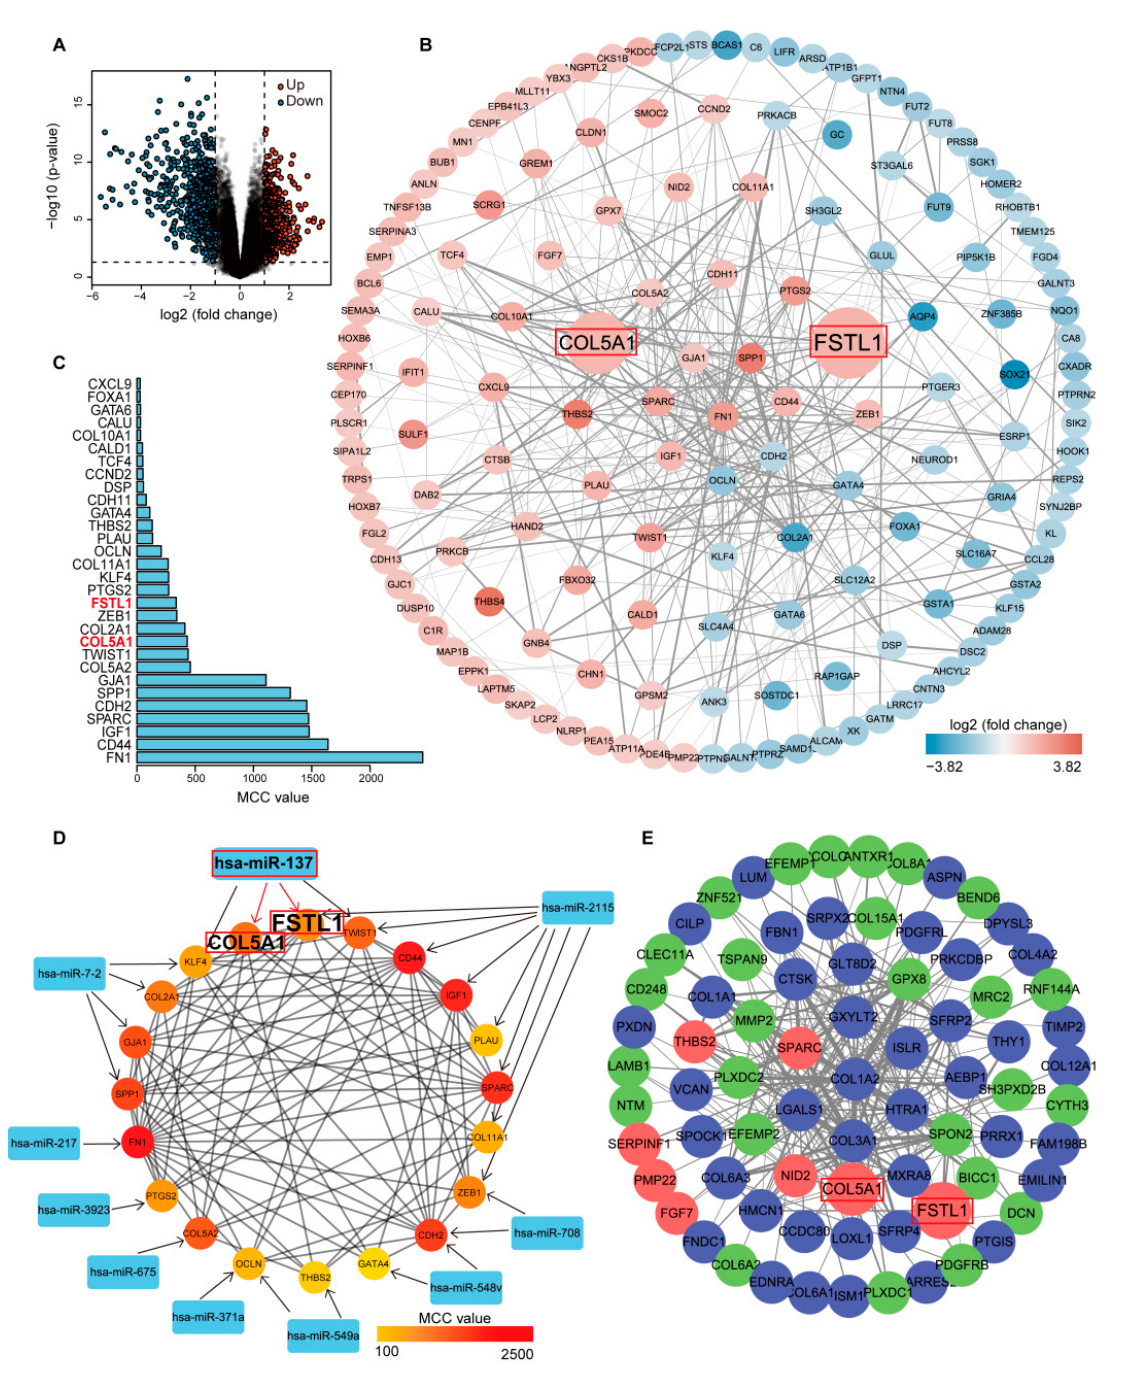
Figure 2. Mining of hub genes in GC. ( A ) Volcano plot of DEGs in GSE118916. ( B ) PPI network of DETGs. Red represents upregulation, and blue represents downregulation. The color of the node deepens as the value of |log 2 FC| increases. ( C ) Genes with the top 30 MCC values in the PPI network. ( D ) The PPI network of 20 hub genes and the SRDEMs that target these genes. The color of the node deepens from yellow to red as the MCC value increases. ( E ) Weighted gene co-expression network of the top 250 edges in the dark gray module. Blue represents DEGs, red represents DETGs, and green represents other genes. In this figure, COL5A1, FSTL1, and miR-137-3p are highlighted. Table 2. Two hundred thirty-three DETGs shared by DEGs and the target genes of 11 SRDEMs.